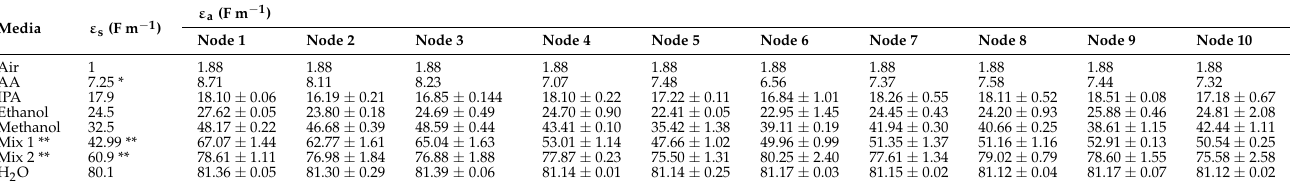
Table 2. Measured ε a and intersensor variability for 10